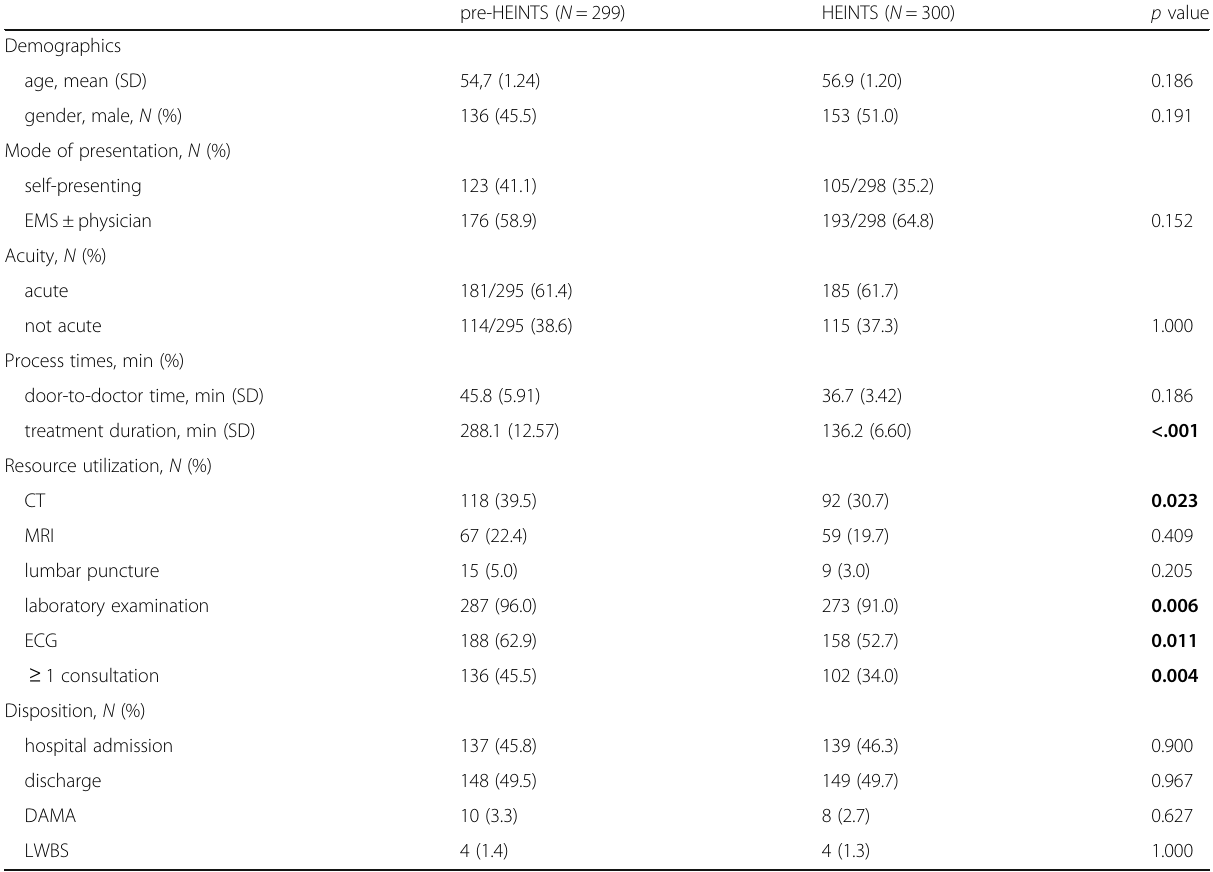
Table 1 Characteristics of pre-HEINTS and HEINTS